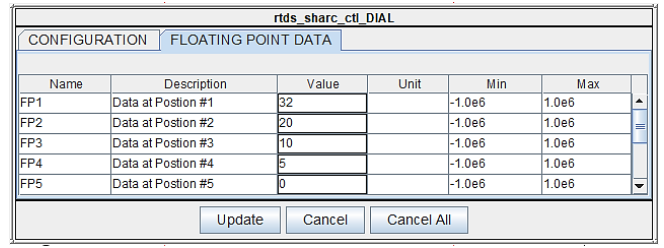
Figure 13. Settings for slider pitch angle values in degrees of rotation.